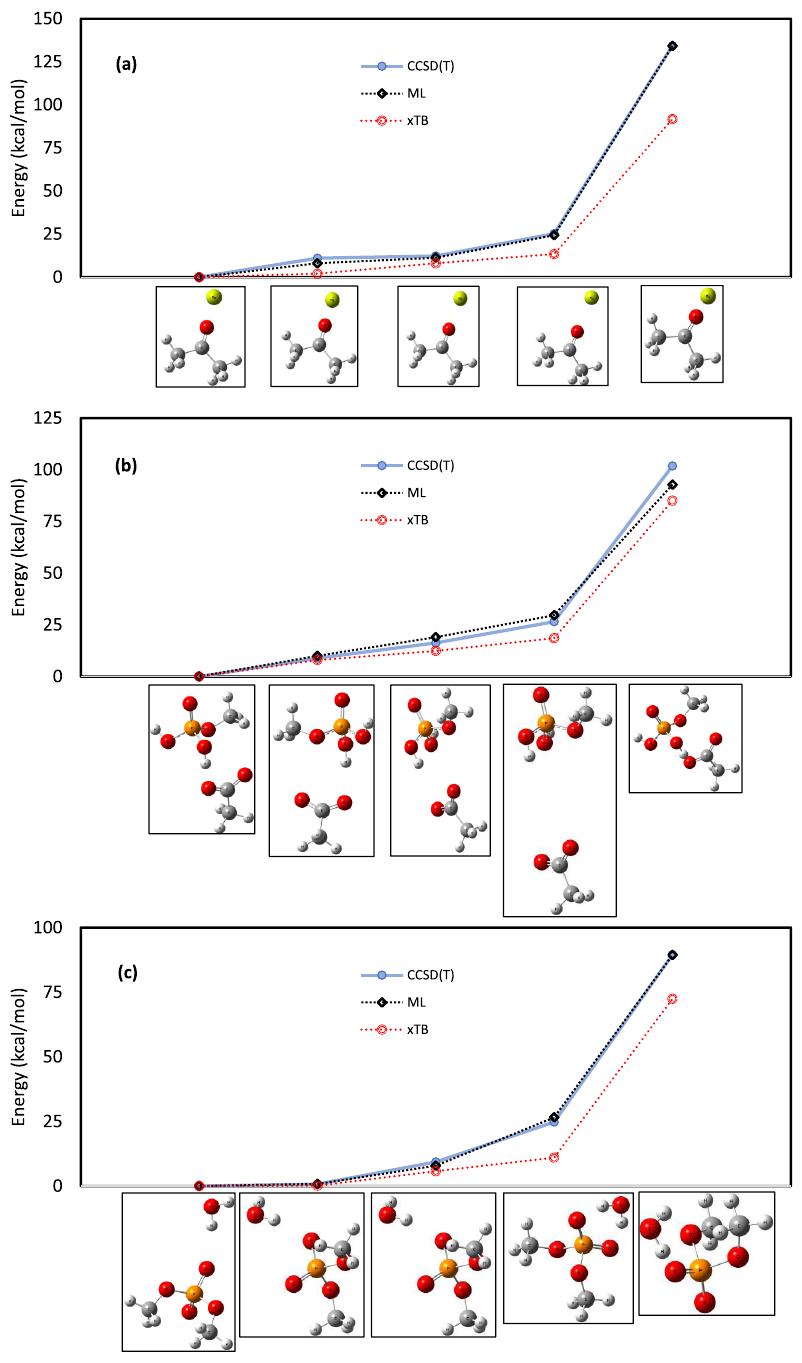
Fig. 3 Comparison of reference CCSD(T) energies and predicted energies in different conformers. For three dimers ( a ), ( b ), and ( c ) which showed the highest variability in energy range among conformers, employing machine learning and ImPerHam representations remarkably improves the agreement between predicted and reference